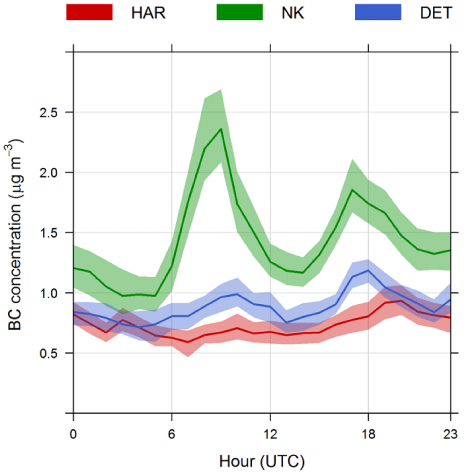
Figure 5. Mean diurnal variations in the BC concentrations at 880nm during the winter campaign as measured by a 2W AE, with the shaded areas indicating the 95% confidence intervals. Note that in the key, HAR and DET represent Harwell and Detling respec-